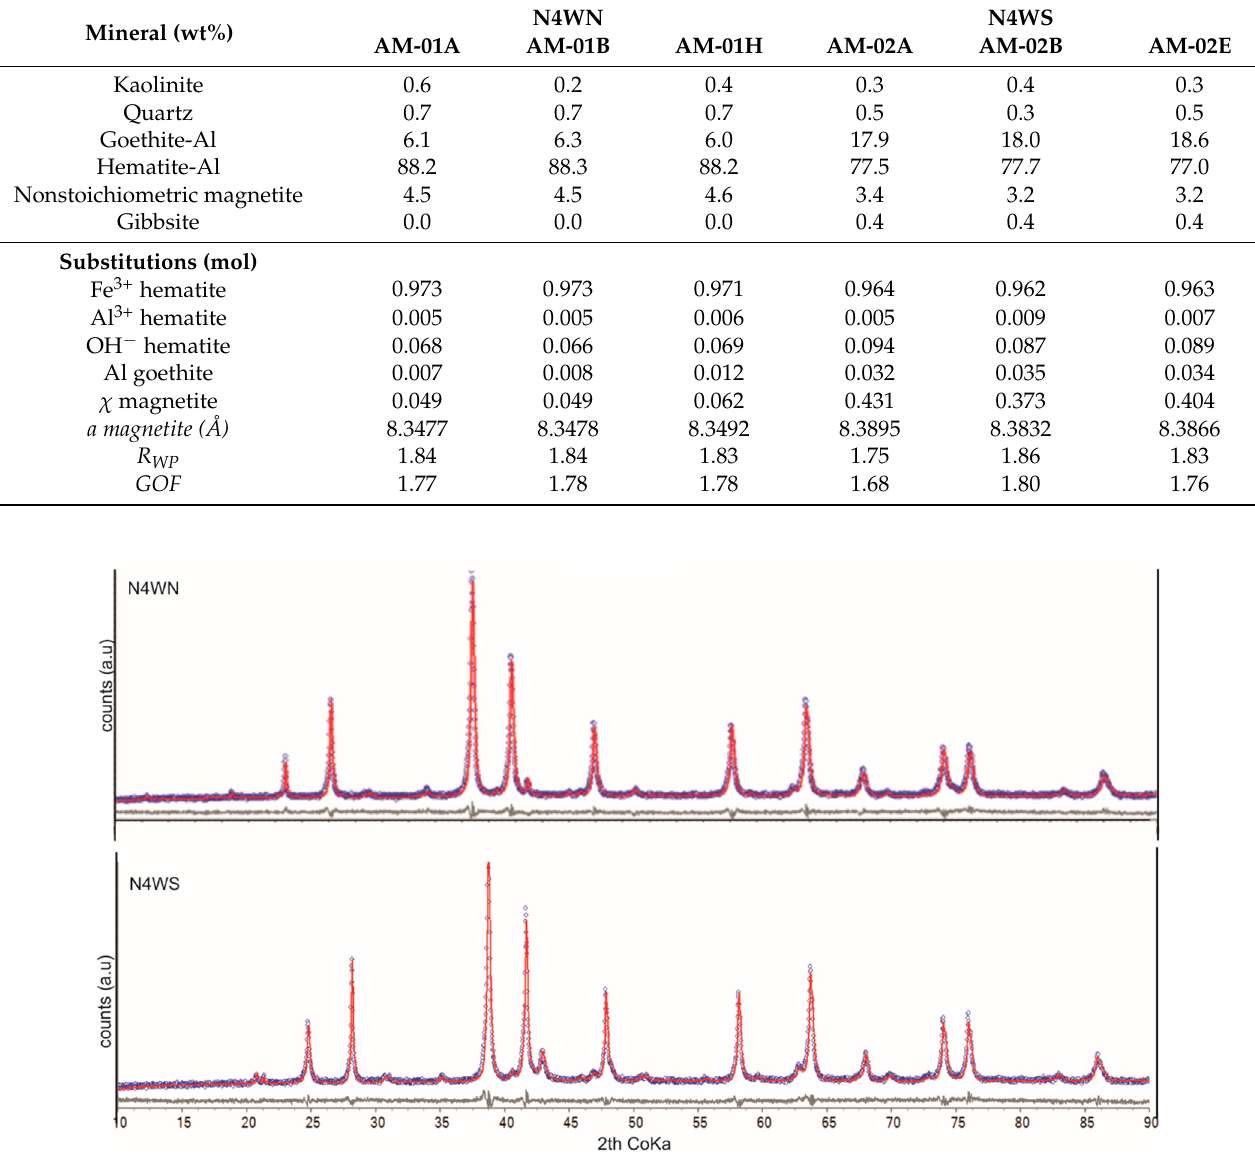
Figure 4. Rietveld method refinement results for the Carajás N4WN and N4WS samples. Measured and calculated patterns as blue circles and red lines, respectively, residue as the gray line at the bottom.